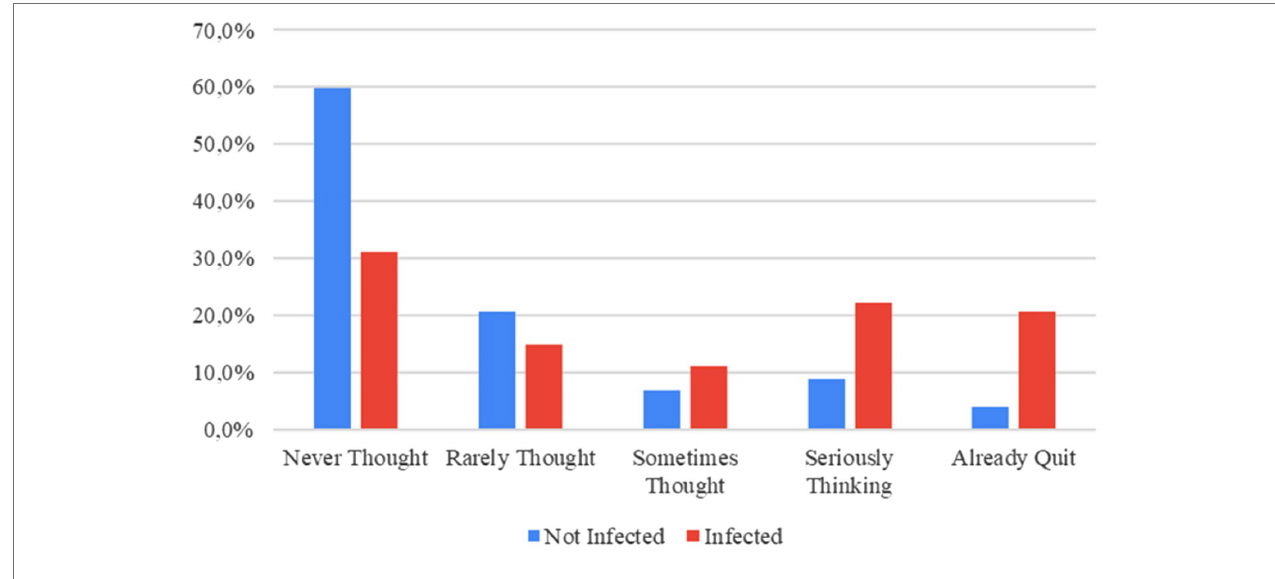
FIGURE 1 | Quitting Jobs.